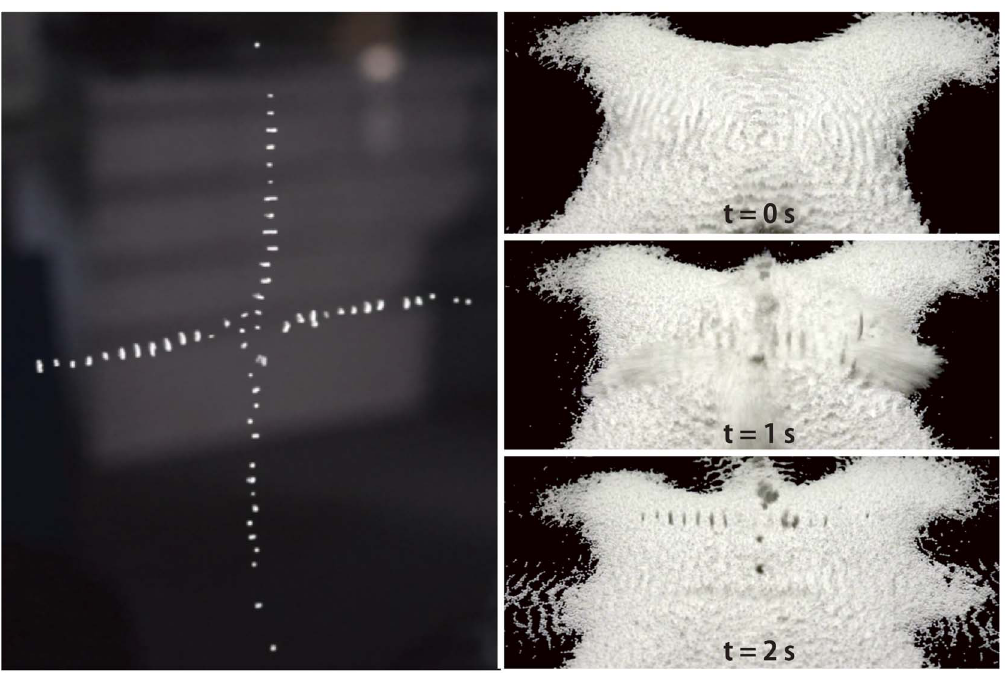
Figure 4. Manipulation of particles. (Left) Levitation and manipulation of particles with the vertical setup shown in Figure 3. (Right) Scooping up and holding particles with the horizontal setup in which all the ultrasonic beams are horizontally radiated.